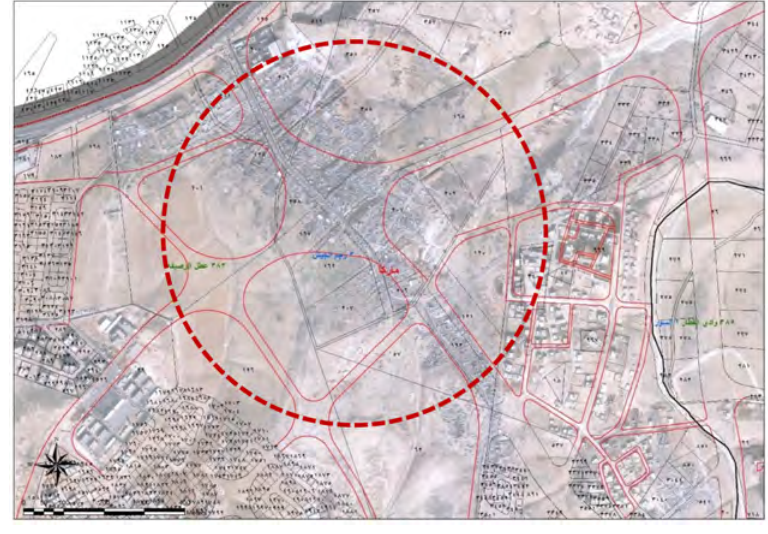
Figure 24. Scrap yard site aerial view map. Source: GAM- GIS for the author (2016).